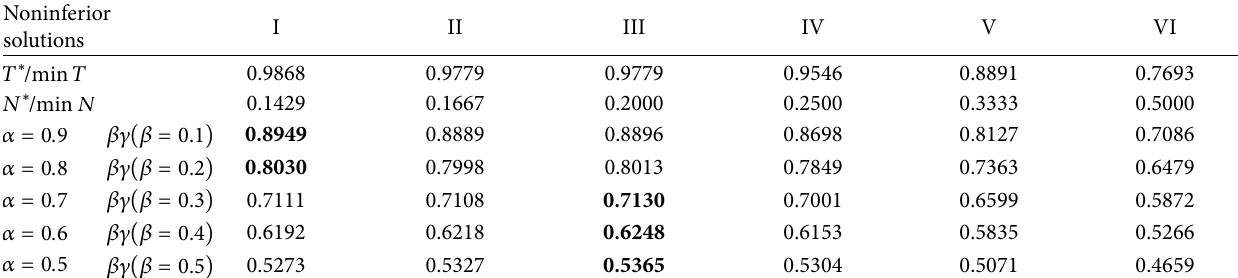
Table 6: The transshipment efficiency (ETN) for various weights.